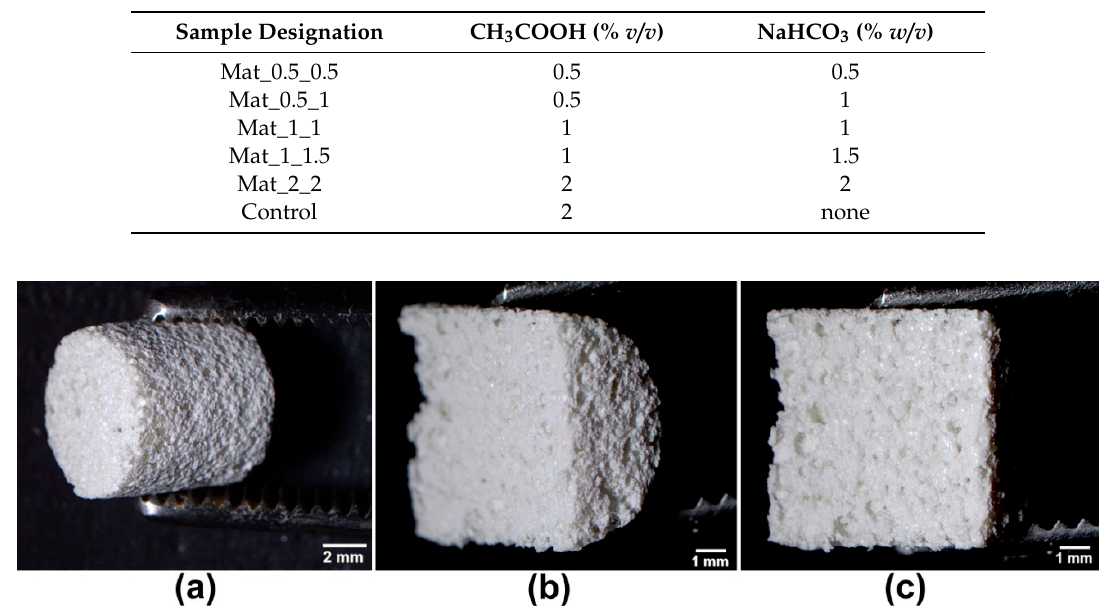
Figure 1. Stereoscopic microscope images presenting microstructure of the mat_2_2 scaffold: ( a ) Stereoscopic microscope images presenting microstructure of the mat_2_2 sca ff old: produced scaffold (scale bar = 2 mm); ( b ) and ( c ) longitudinal sections representing the exact middle ( a ) produced sca ff old (scale bar = 2 mm); ( b , c ) longitudinal sections representing the exact middle of the mat_2_2 (scale bar = 1 mm).